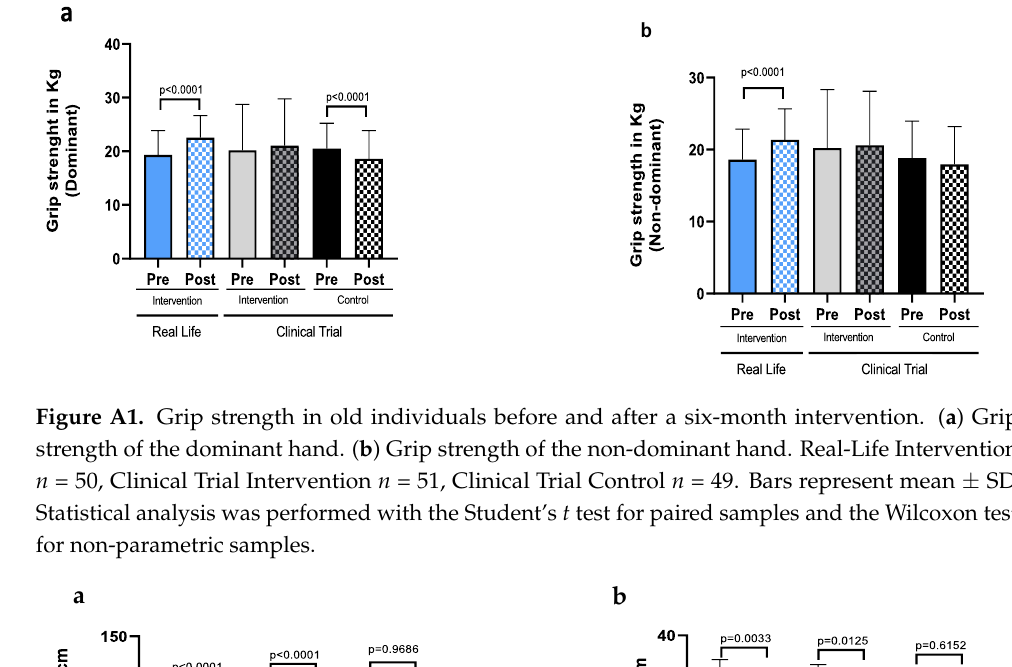
Each participant walked at the speed necessary to maintain heart rate within the indicated range for each session.